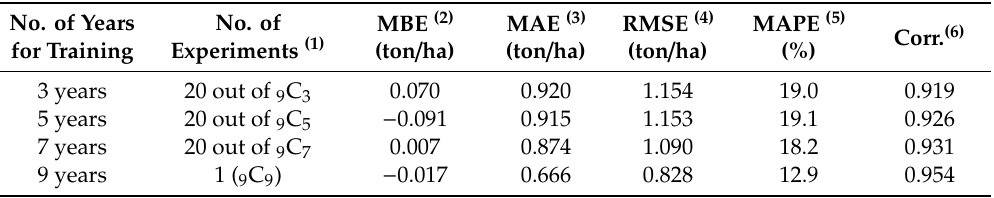
Table 5. Summary of validation statistics according to the number of years used in training for prediction of corn yield in 2012 as a drought case.